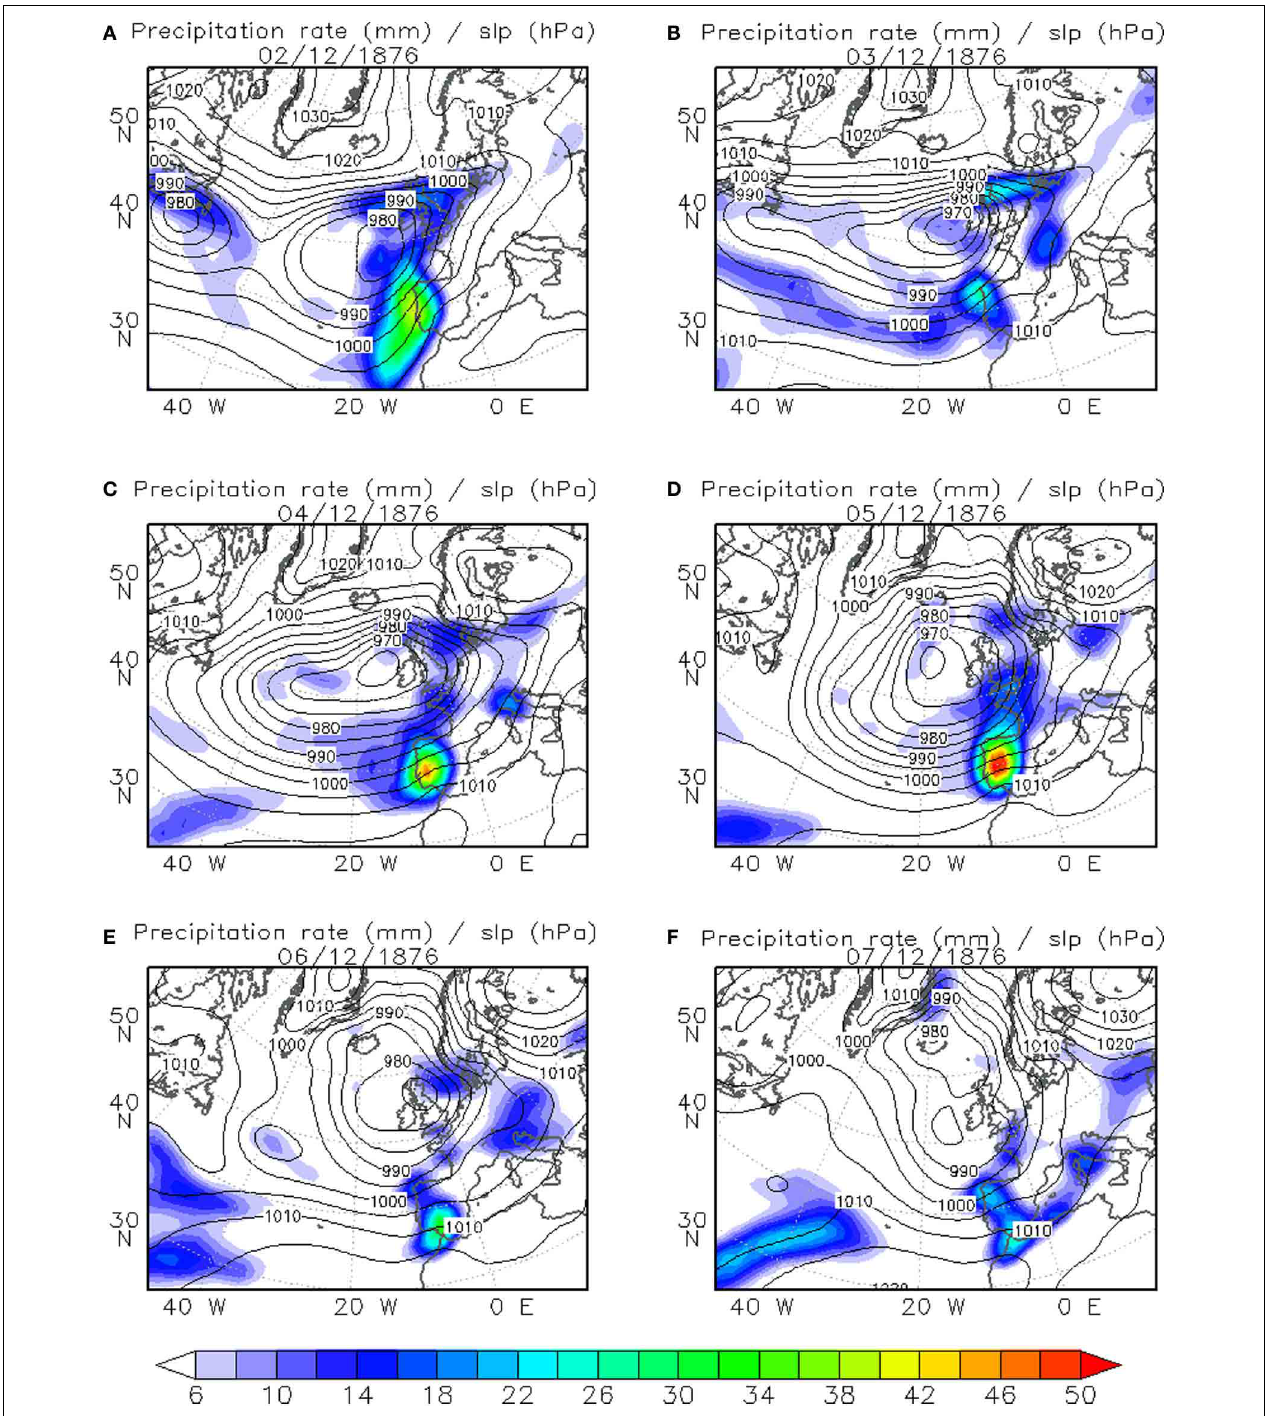
FIGURE 11 | Daily mean precipitation intensity colors (mm) and daily mean sea level pressure, contours (hPa), for: (A) 02/12/1876; (B) 03/12/1876; (C) 04/12/1876; (D) 05/12/1876; (E) 06/12/1876; (F) 07/12/1876.